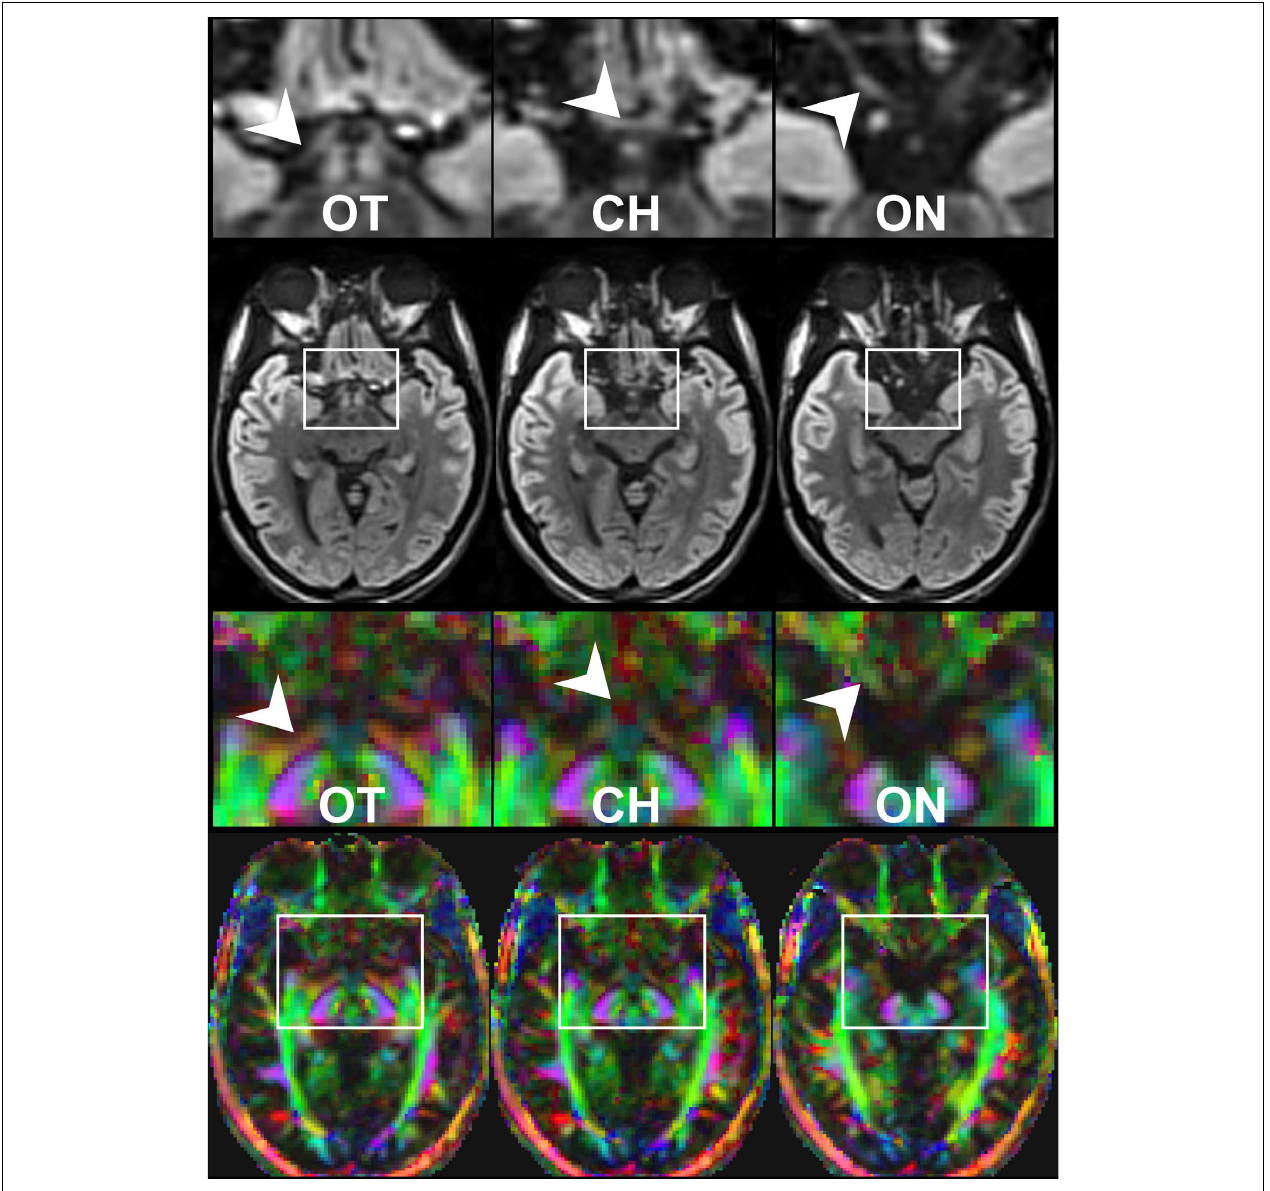
isotropic spatial resolution (magnifi ed views on top, arrowheads indicate respective areas). OT, optic tract; CH, chiasm; ON, optic nerve. Green = anterior–posterior, blue = superior–inferior, red =